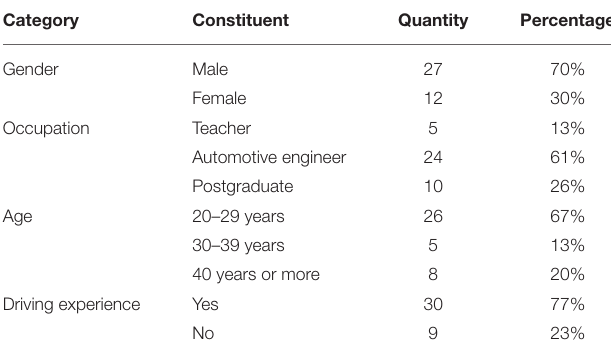
TABLE 2 | Characteristic distribution of